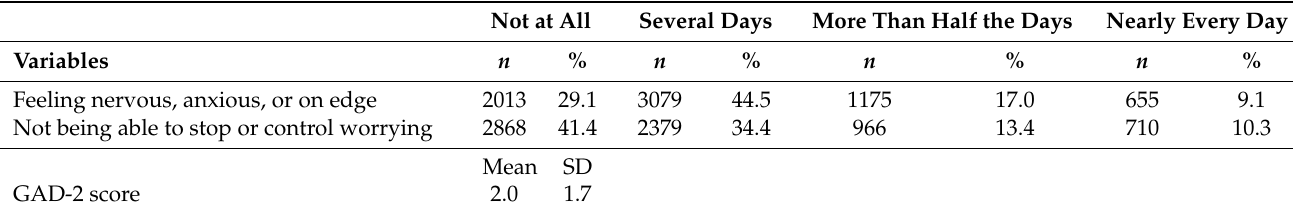
Table 4. Anxiety assessed with the GAD-2 ( n =